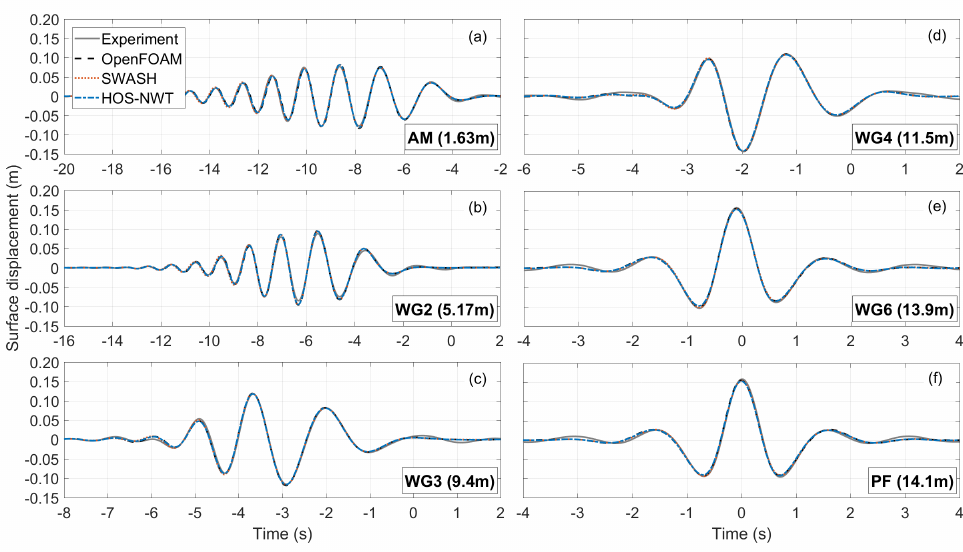
Figure 8. Comparison of the free surface elevation of the linear harmonics between the numerical models and the experiment at different locations ( a – f